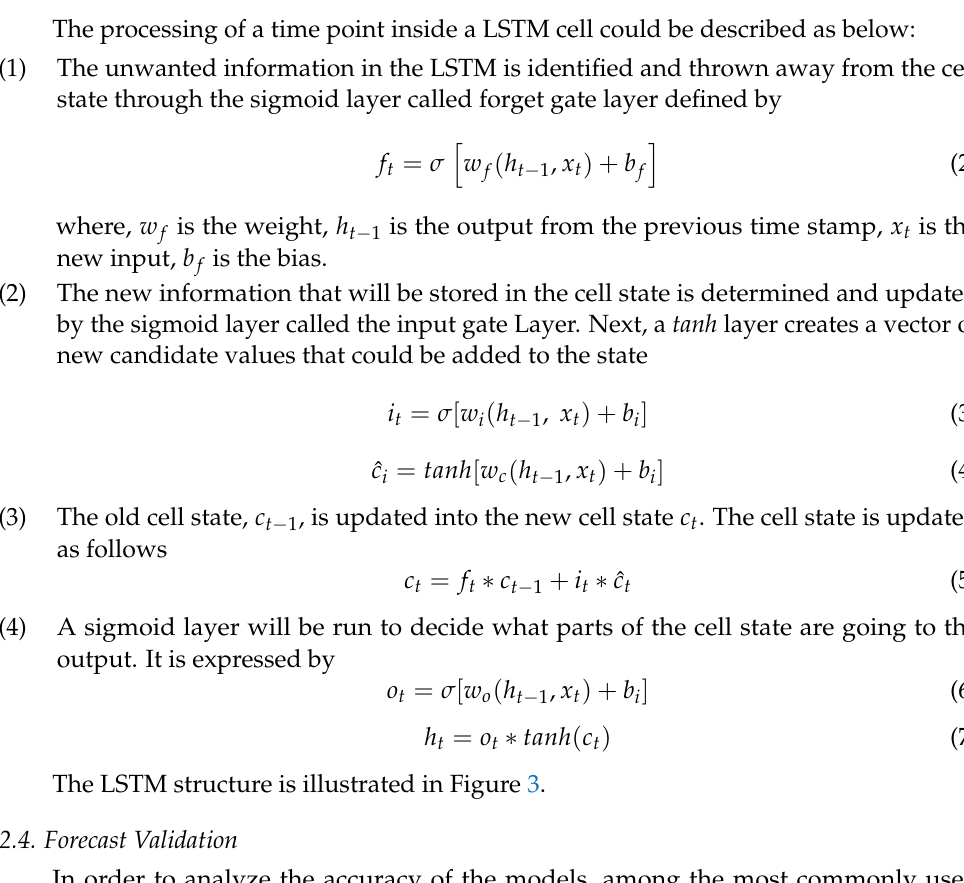
Figure 2. RNN Figure 2. RNN structure.